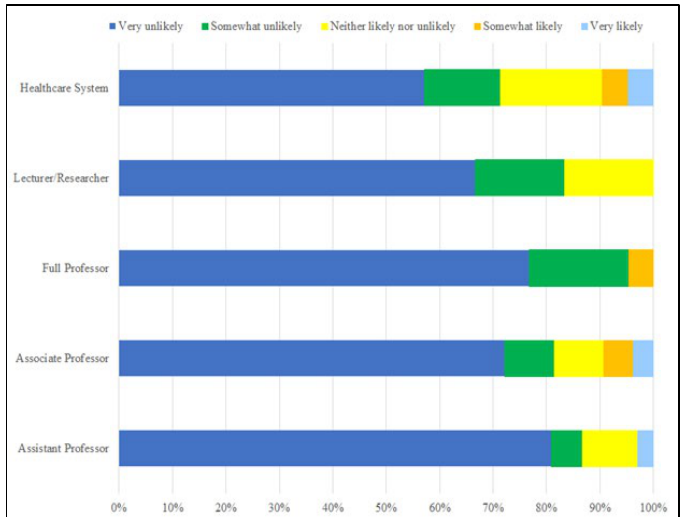
Figure 2 Responses to survey question: “What is the likelihood that any of your articles were published in a journal that is (possibly) predatory?” by Position Title